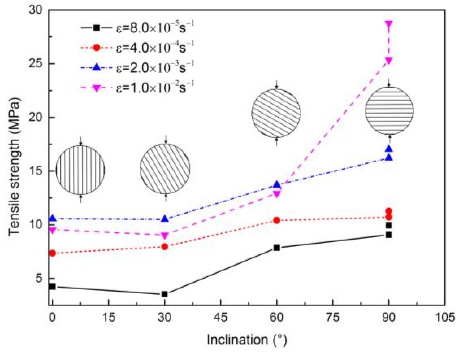
Figure 4. The relationship between tensile strength and bedding plane orientation.